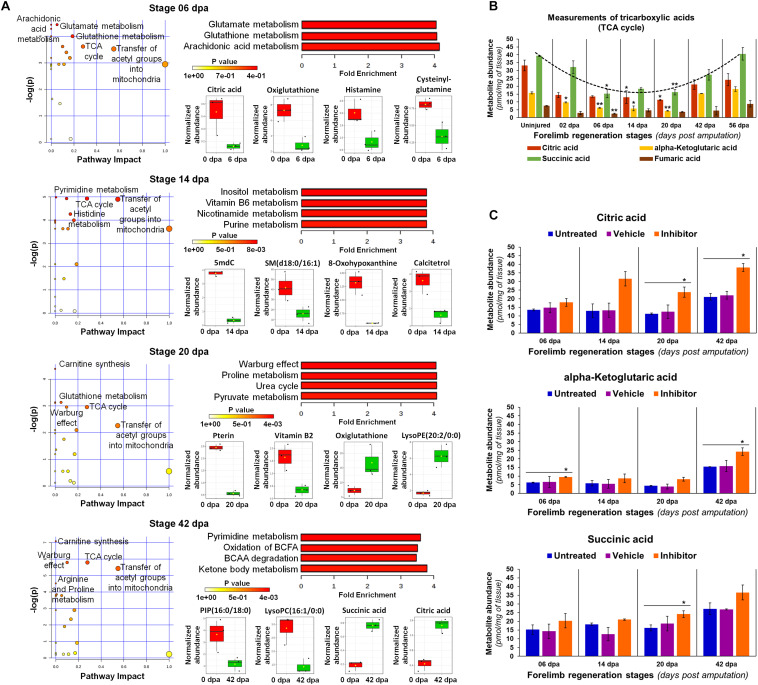
Metabolic analyses in key regeneration stages. (A) Pathway analysis by global network topology evaluation with relative-betweenness centrality measure to estimate the importance of nodes. Different dot sizes represent the matched pathway status. Quantitative Metabolite Set Enrichment Analysis (QMSEA) is shown next with the metabolite sets more enriched only, using human pathway-associated metabolite sets SMPDB as reference through a global test. The box and whisker plots display some representative metabolites with a significant differential abundance (2-fold change threshold, P < 0.05 with unpaired t-Student test vs uninjured condition). BCFA: branched-chain fatty acids; BCAA: branched-chain amino acids. (B) Abundance validation of some tricarboxylic acids (TCA). Illustrative trend line for succinic acid is shown in a dotted line (R2 > 0.9). Data in the bar plot are represented as mean ± s.e.m. (n = 3); *, P < 0.05; one-way ANOVA with post hoc Tukey–Kramer test vs uninjured condition. (C) Quantification of some tricarboxylic acids after diverse treatments. Inhibitor was the Lin28-1632, and the vehicle 0.75× PBS with 0.002% DMSO. Data in the bar plots are represented as mean ± s.e.m. (n = 3); *, P < 0.05; one-way ANOVA with post hoc Dunnett test vs untreated control condition.